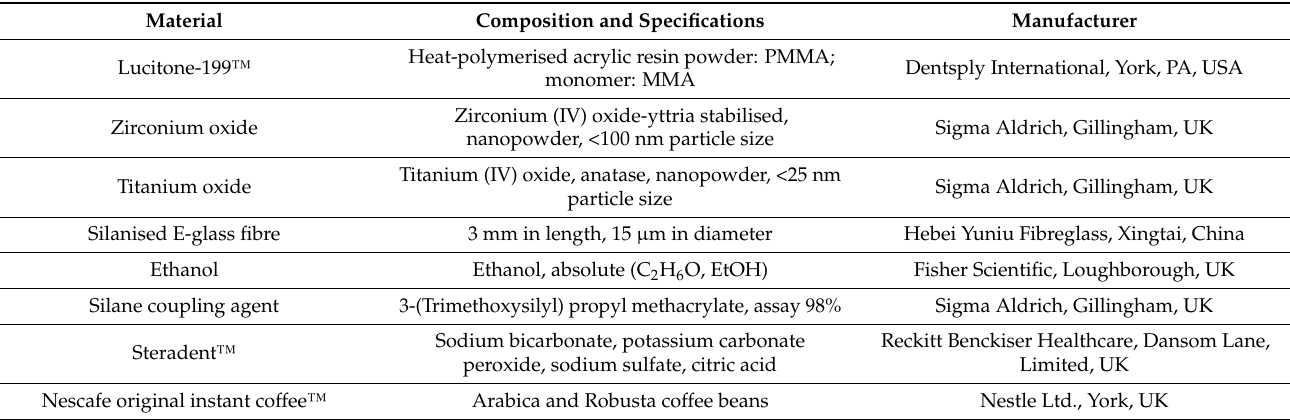
Table 1. Materials utilised in the current